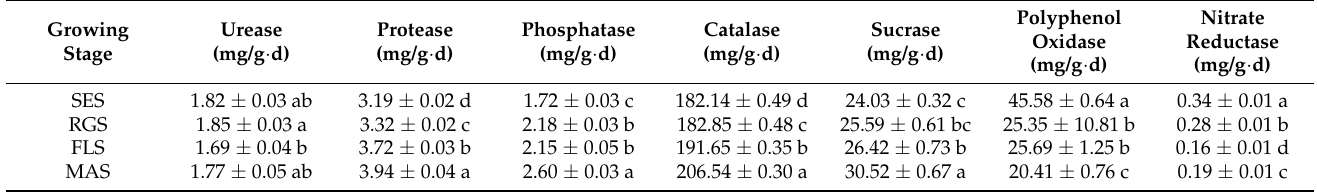
Table 3. Effect of different growth stages on rhizosphere soil enzyme activity in industrial hemp.